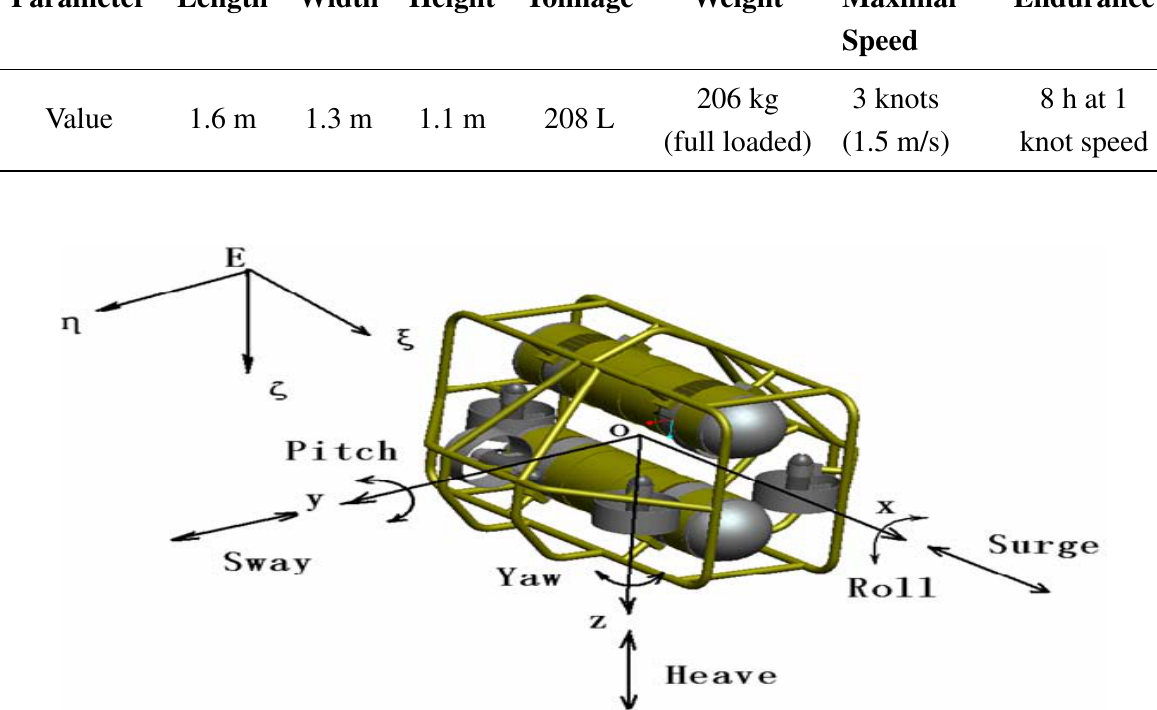
Table 4. Essential parameters of the C-Range autonomous underwater vehicle (AUV). Parameter